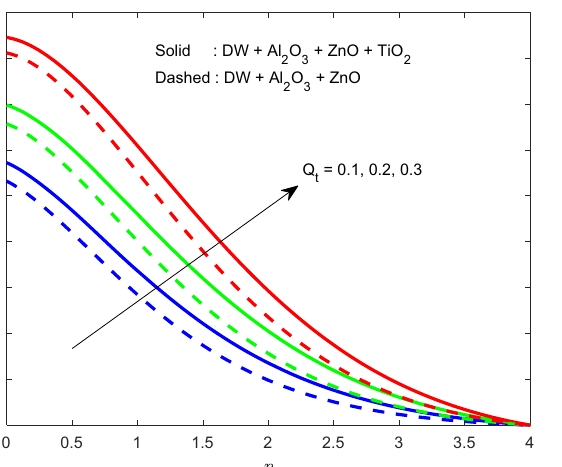
Figure 9: Increasing e ff ects of Q t on θ ( η ) .